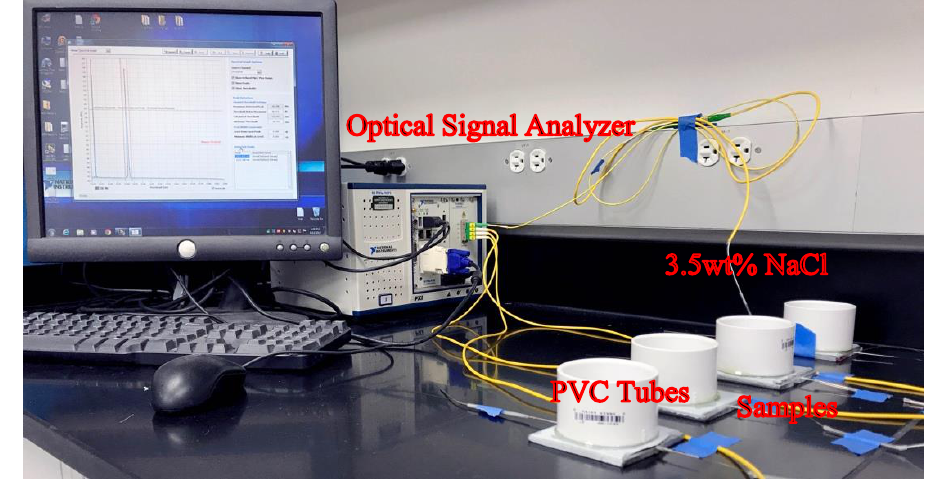
Figure 2. Accelerated corrosion test set-up.